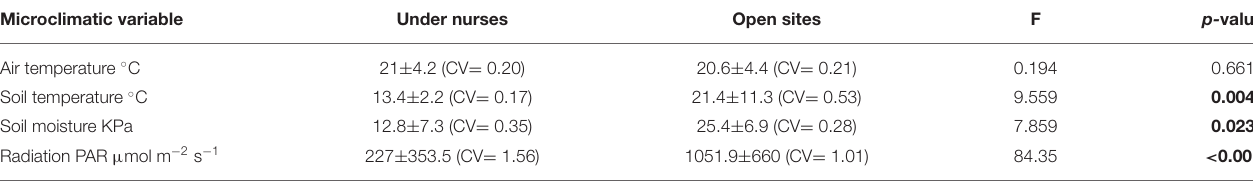
TABLE 1 | One-way ANOVAs of the microclimatic variables measured under nurses and in open sites. Microclimatic variable